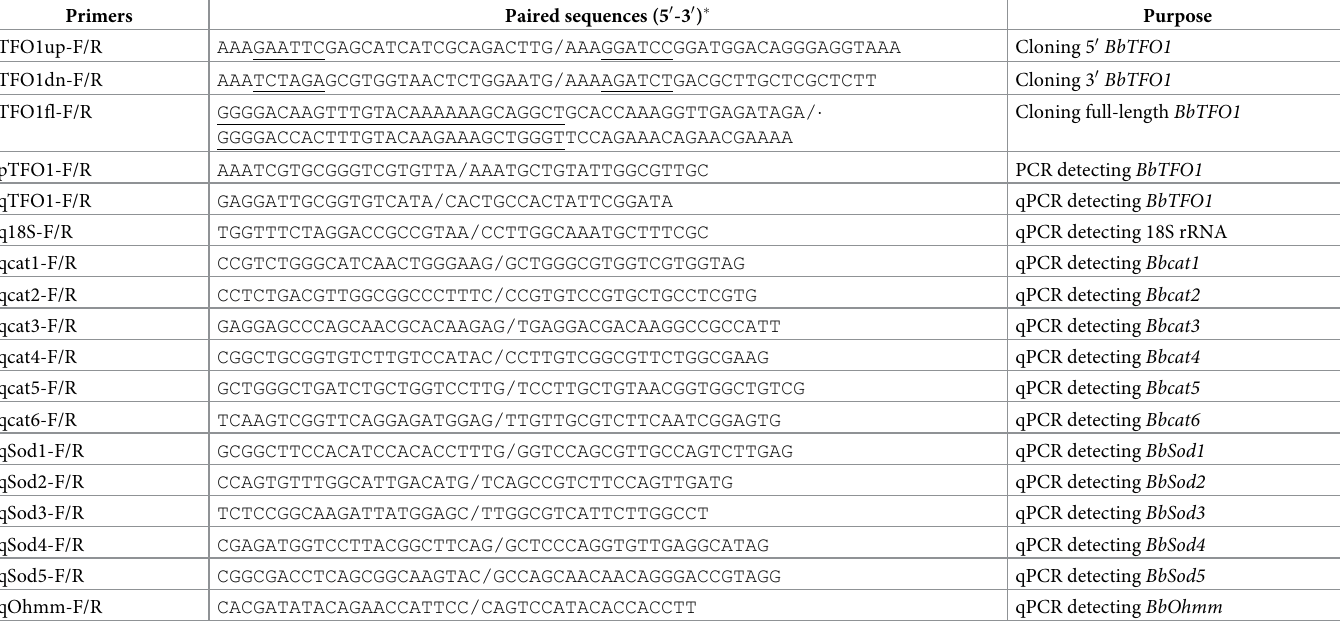
Table 1. Paired primers used for gene cloning, deletion, complement and expression.